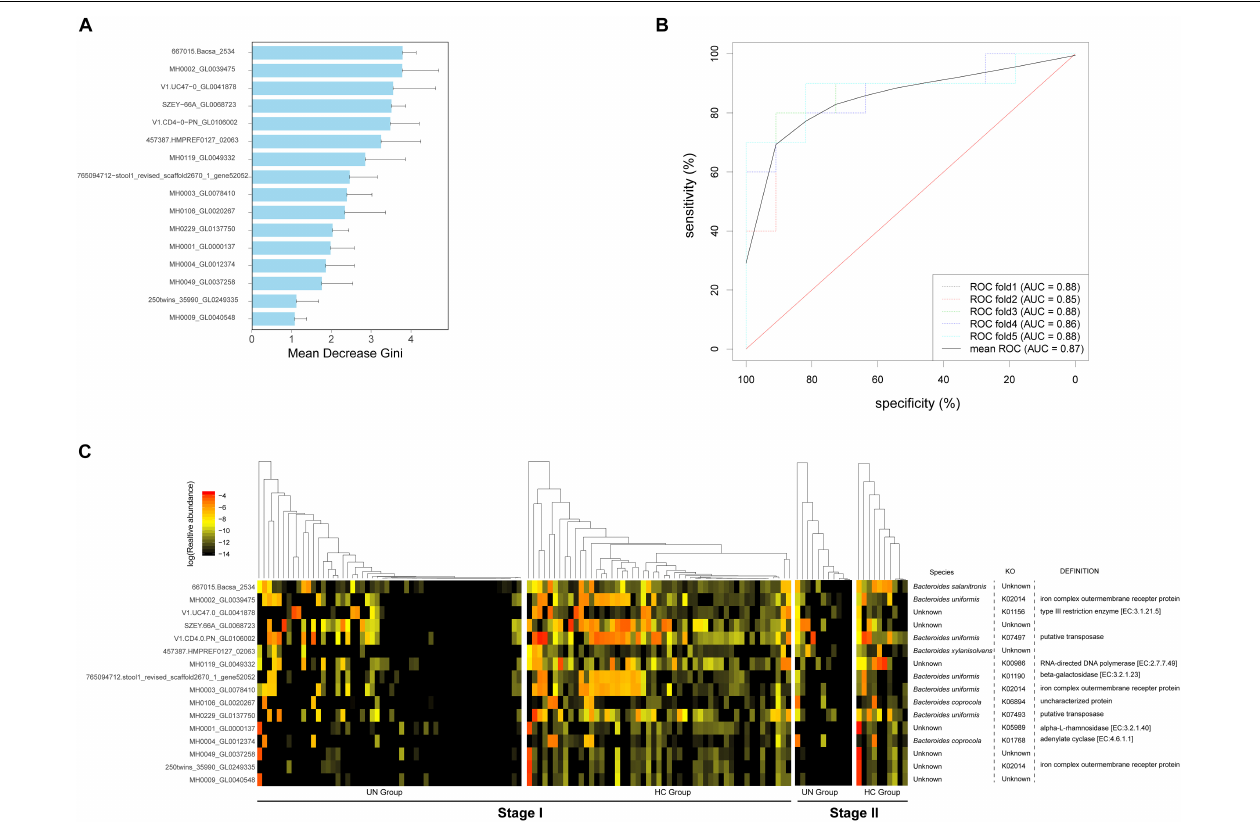
FIGURE 3 | Bacterial gene markers and their validation accuracy for the discrimination of UN patients. (A) Following the optimal variation numbers indicated by Random Forest classifiers, 16 gene biomarkers with Gini values applied to indicate their contributions to the discrimination between the UN group and the HC group classification, were selected at stage I. (B) These gene markers were tested in the samples from stage II, and their AUC values were calculated. The ROC curves were drawn with five repeats in different colors. (C) The log 10 relative abundances of the gene markers were detected for all samples; the species, KEGG pathways, and functions corresponding to the biomarkers are also